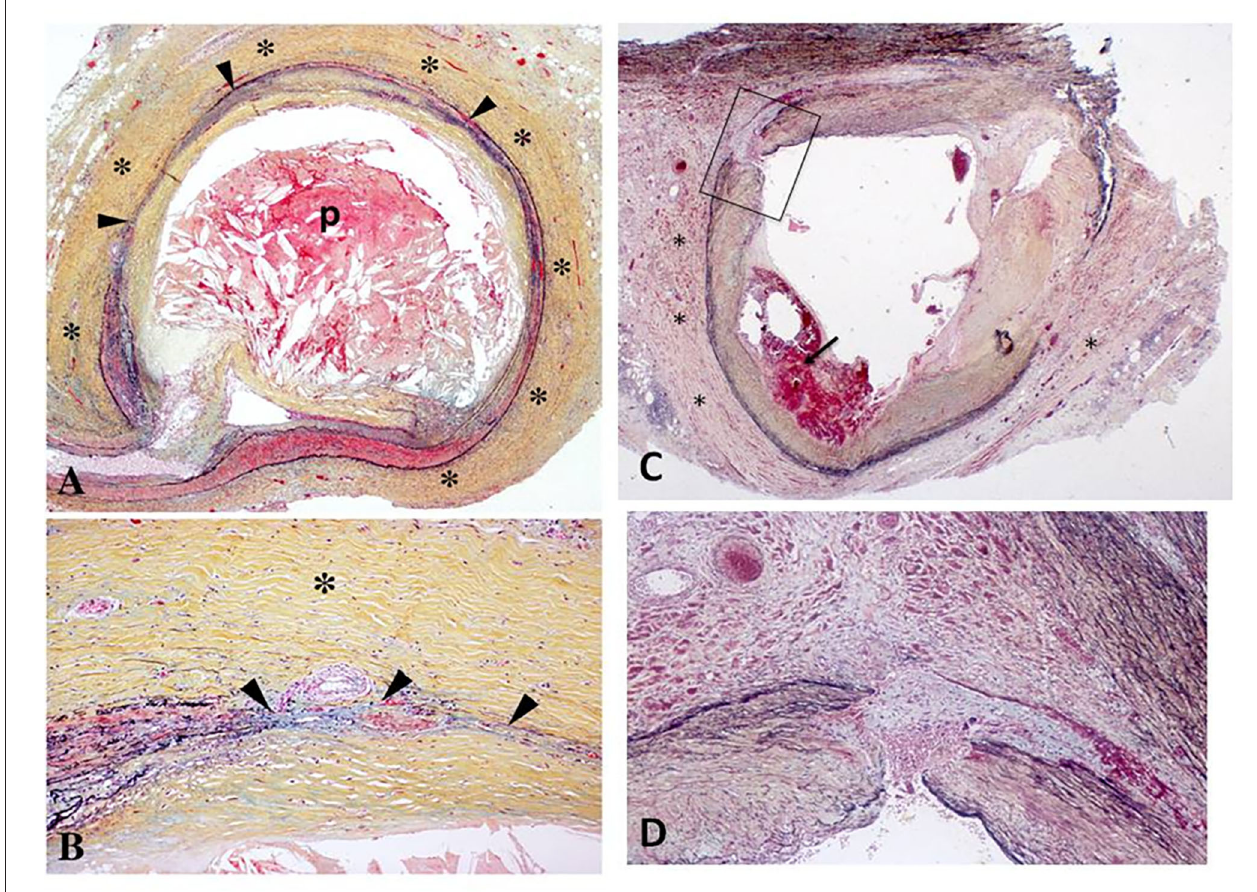
FIGURE 2 | (A,B) Histologic section of the left circumflex coronary artery from a 67-year-old patient who received radiation therapy for carcinoma of the lung 7 years prior to sudden death. Low power view (A) demonstrates severe adventitial fibrosis (*) and focally extensive destruction of the media (arrowheads) with intimal plaque (p) causing 75% luminal narrowing. The plaque consists mostly of necrotic core that is rich in cholesterol clefts. Note a markedly thickened adventitia (*) at high power (B) with medial destruction (arrowheads) [Reproduced with permission from (9)]. (C,D) Right coronary artery from a 62-year old man with mediastinal radiation therapy for Hodgkin’s disease 25 years antemortem. At autopsy, there was 70% lumen area narrowing (C) with intraplaque hemorrhage (arrow), marked adventitial fibrosis (*), and focal destruction of the arterial media (arrowheads). The boxed in area in (A) is shown at higher magnification in (B) ; note medial disruption (arrowheads) and replacement by smooth muscle cells in a collagenous matrix [Reproduced with permission from